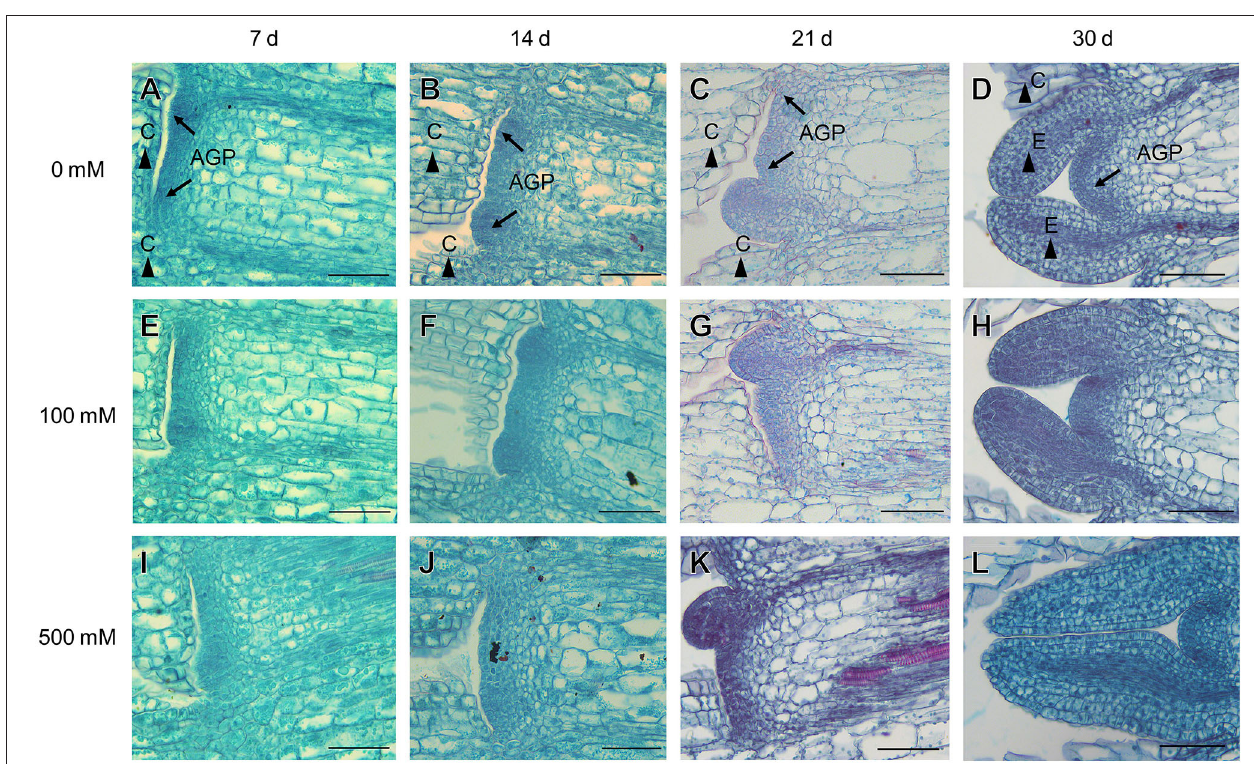
FIGURE 2 | Anatomic structures of the apical growth point (AGP), cotyledon (C), and euphylla (E) of S. aralocaspica after seedling emergence under different salt stress conditions. (A–D) without NaCl treatment; (E–H) 100mM NaCl; (I–L) 500mM NaCl. 7 d, 14 d, 21 d, 30 d: represent different developmental days. Scale bar is 50 µ m.